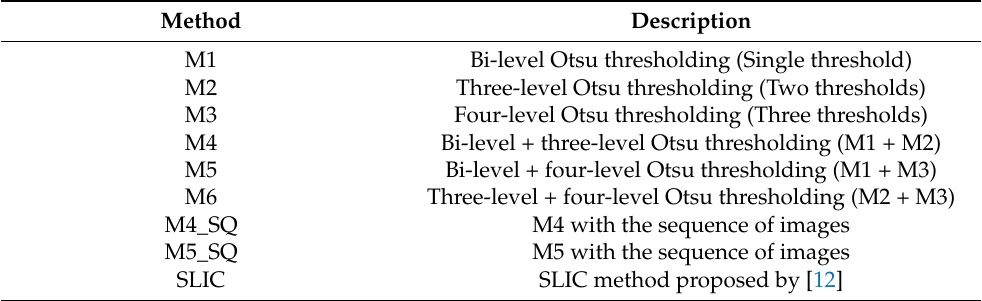
Table 2. Proposed leaf detection